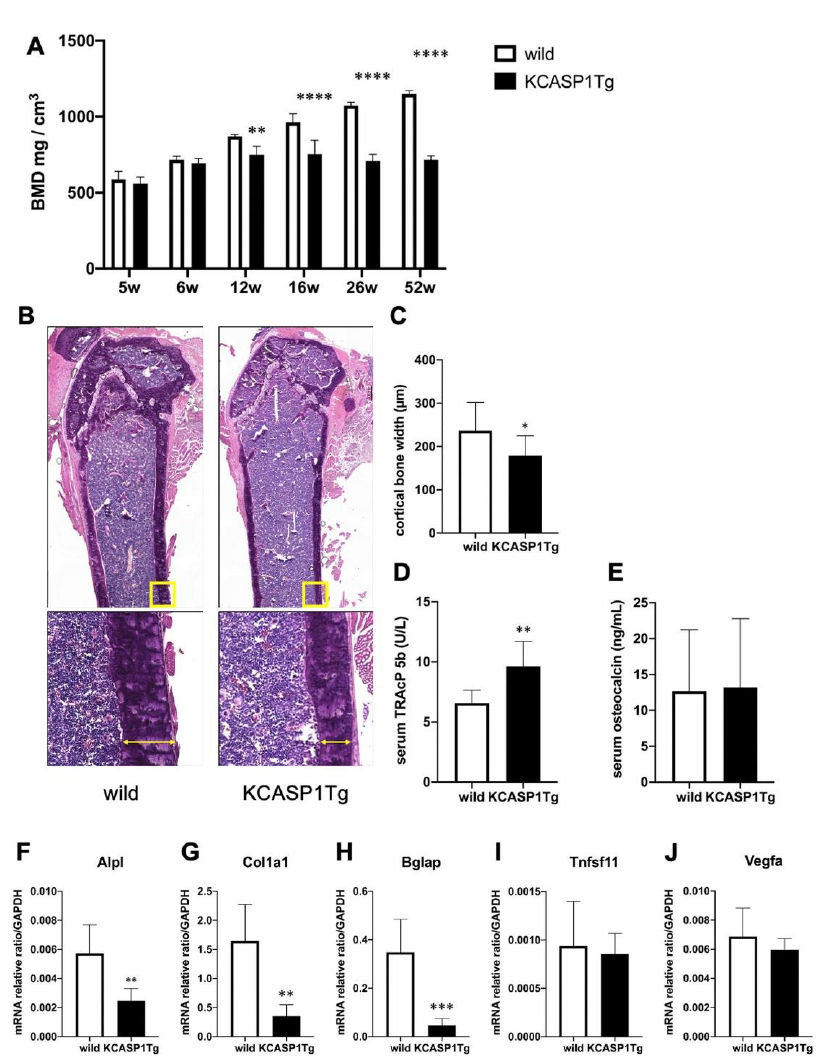
Figure 1. Bone mineral density (BMD) and expression of mRNAs associated to bone formation or destruction in the femur of KCASP1Tg and wild-type mice. BMD was scanned at the distal end of the right femur in KCASP1Tg and wild-type littermates of 5 to 52 weeks of age ( n = 4 per group). In KCASP1Tg mice, BMD decreased significantly compared to wild-type littermates at 12 weeks of age ( A ). The cortical bone width was measured in HE (upper panel × 40, lower panel × 100). Four parts ( n = 3 per group) were randomly selected and measured by using Analysis Application Hybrid cell count. The cortical width of the femur was significantly thinner in KCASP1Tg mouse, as determined by histological HE staining ( B,C ). Bone remodeling markers including TRACP-5b and osteocalcin were measured in the serum by a specific ELISA kit. The serum level of TRACP-5b is a sensitive marker of bone resorption, and was significantly increased in KCASP1Tg mice ( D ), but the biomarker of bone formation, serum osteocalcin, was unchanged (( E ), n = 8 per group). The expression of relevant mRNAs in the right femur was quantified by real time PCR, and the values were standardized by using GAPDH ( n = 6 per group). The expressions of genes involved in bone formation, such as alkaline phosphatase-( Alpl , ( F )), collagen type I ( Col1a1 , ( G )) and bone gamma-carboxyglutamate protein ( Bglap , osteocalcin, ( H )) were significantly decreased in KCASP1Tg mice. The mRNA levels of genes for osteoclast differentiation and activation, i.e., members of the tumor necrosis factor superfamily ( Tnfsf11 , RANKL , ( I )) and vascular endothelial growth factor ( Vegfa , ( J )) were unchanged in the model mice. All data are expressed as mean ± SD. *; p < 0.05, **; p < 0.01, ***; p < 0.001, ****; p < 0.0001 between KCASP1Tg and wild-type mice by Mann–Whitney (except A) test and ordinary one-way